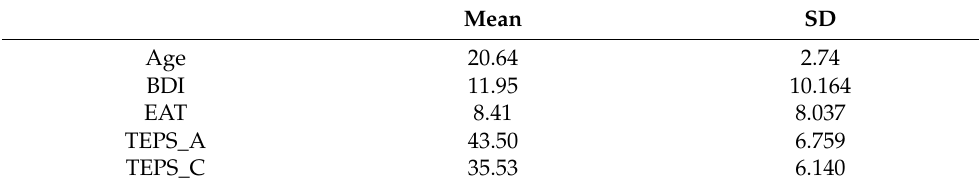
Table 1. Demographic and questionnaire